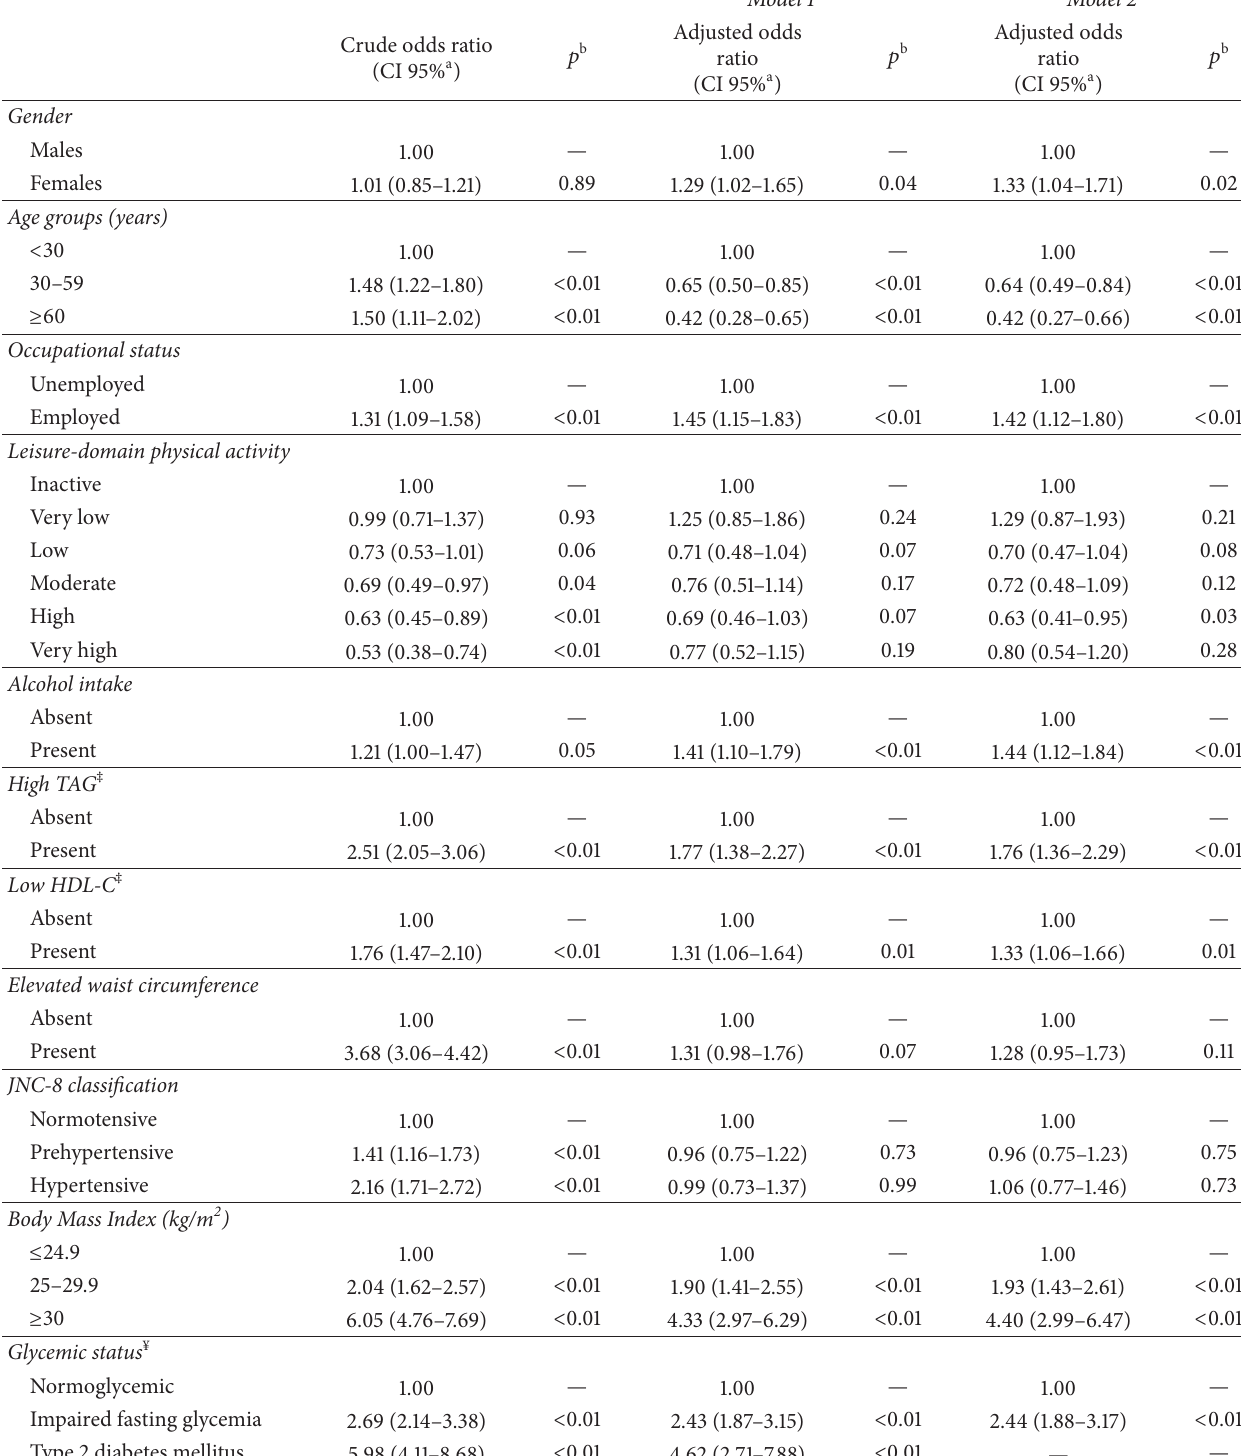
Table 8: Sociodemographic and metabolic risk factors associated with insulin resistance (Maracaibo, Venezuela,